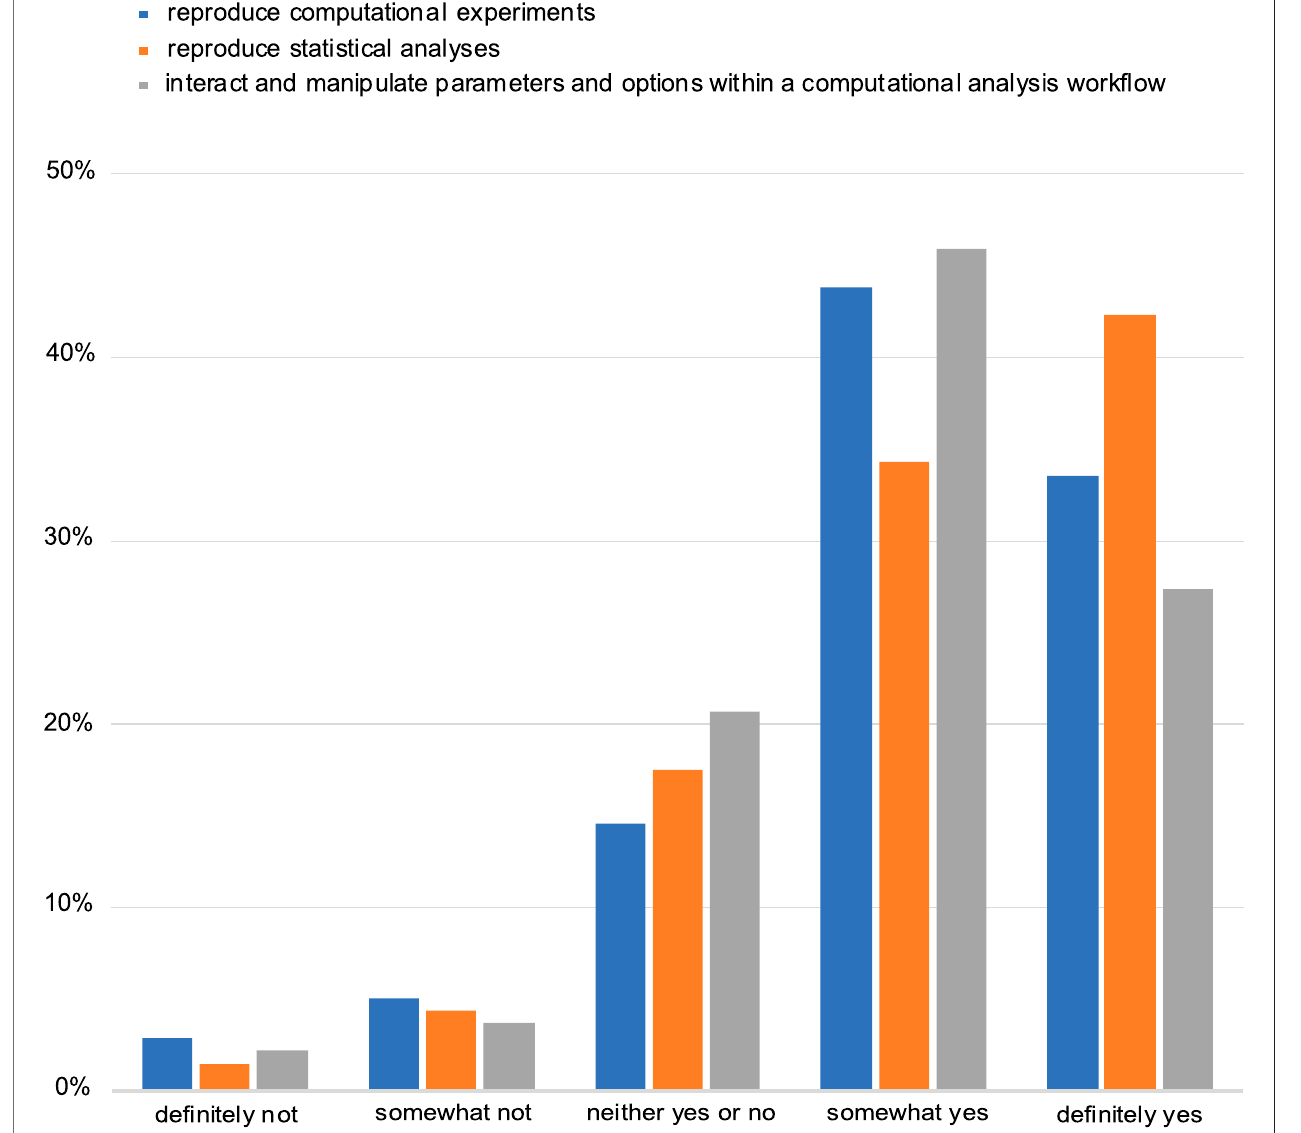
FIGURE 5 | Assessment of perceived bene fi t for automatically reproducing computational experiments or other analyses (including statistical tests). Responses from both NBI and eLIFE for question 14.